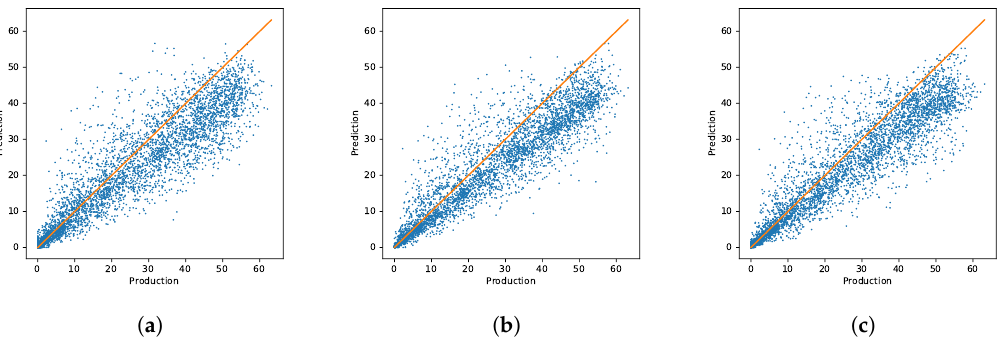
Figure 2. Real energy production against prediction made by the best CTL ( a ), ITL ( b ), and MTL ( c ) models in majorca in terms of MAE; the perfect prediction line is shown in orange. The units of the axis are MWh.